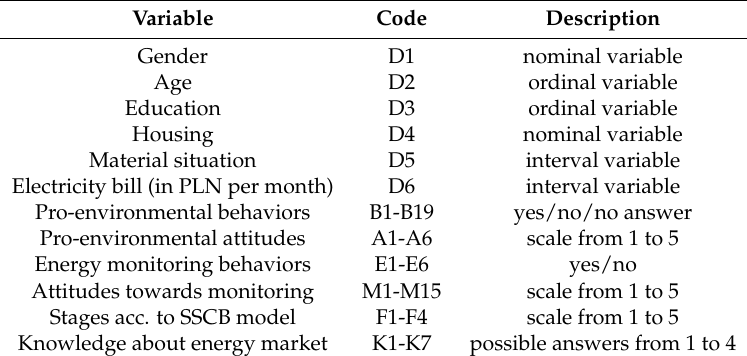
Table 1. Definitions of the variables and coding (N =